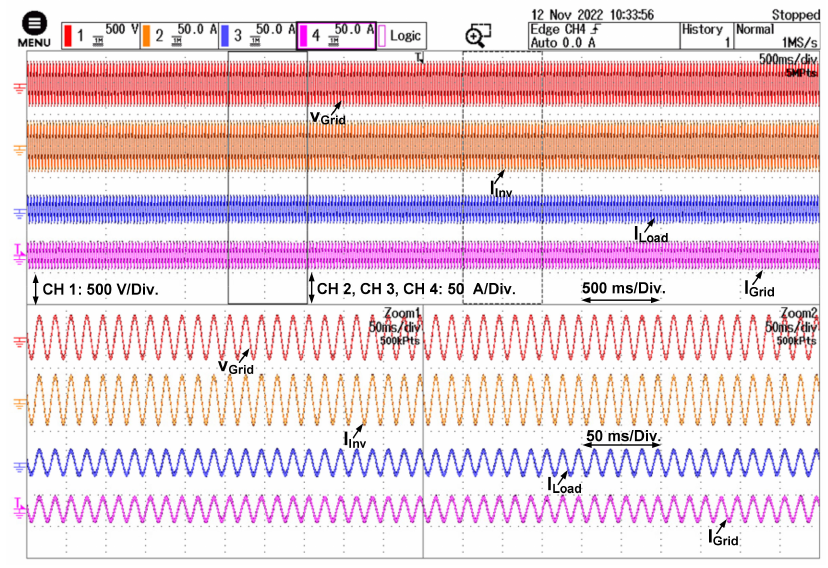
Figure 25. Experimental waveforms under partial shading of V Grid , I Inv , I Load , and I Grid